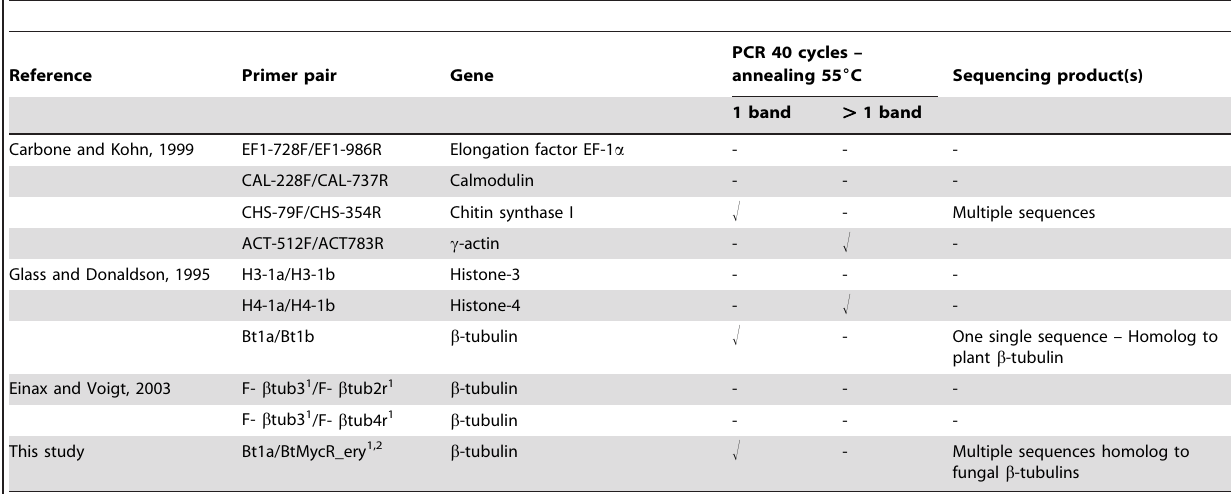
Table 2. PCR and sequencing efficiencies on oak powdery mildews, Erysiphe alphitoides and E. quercicola , obtained with fungal primers developed in Carbone and Kohn (1999), Glass and Donaldson (1995) and Einax and Voigt (2003).